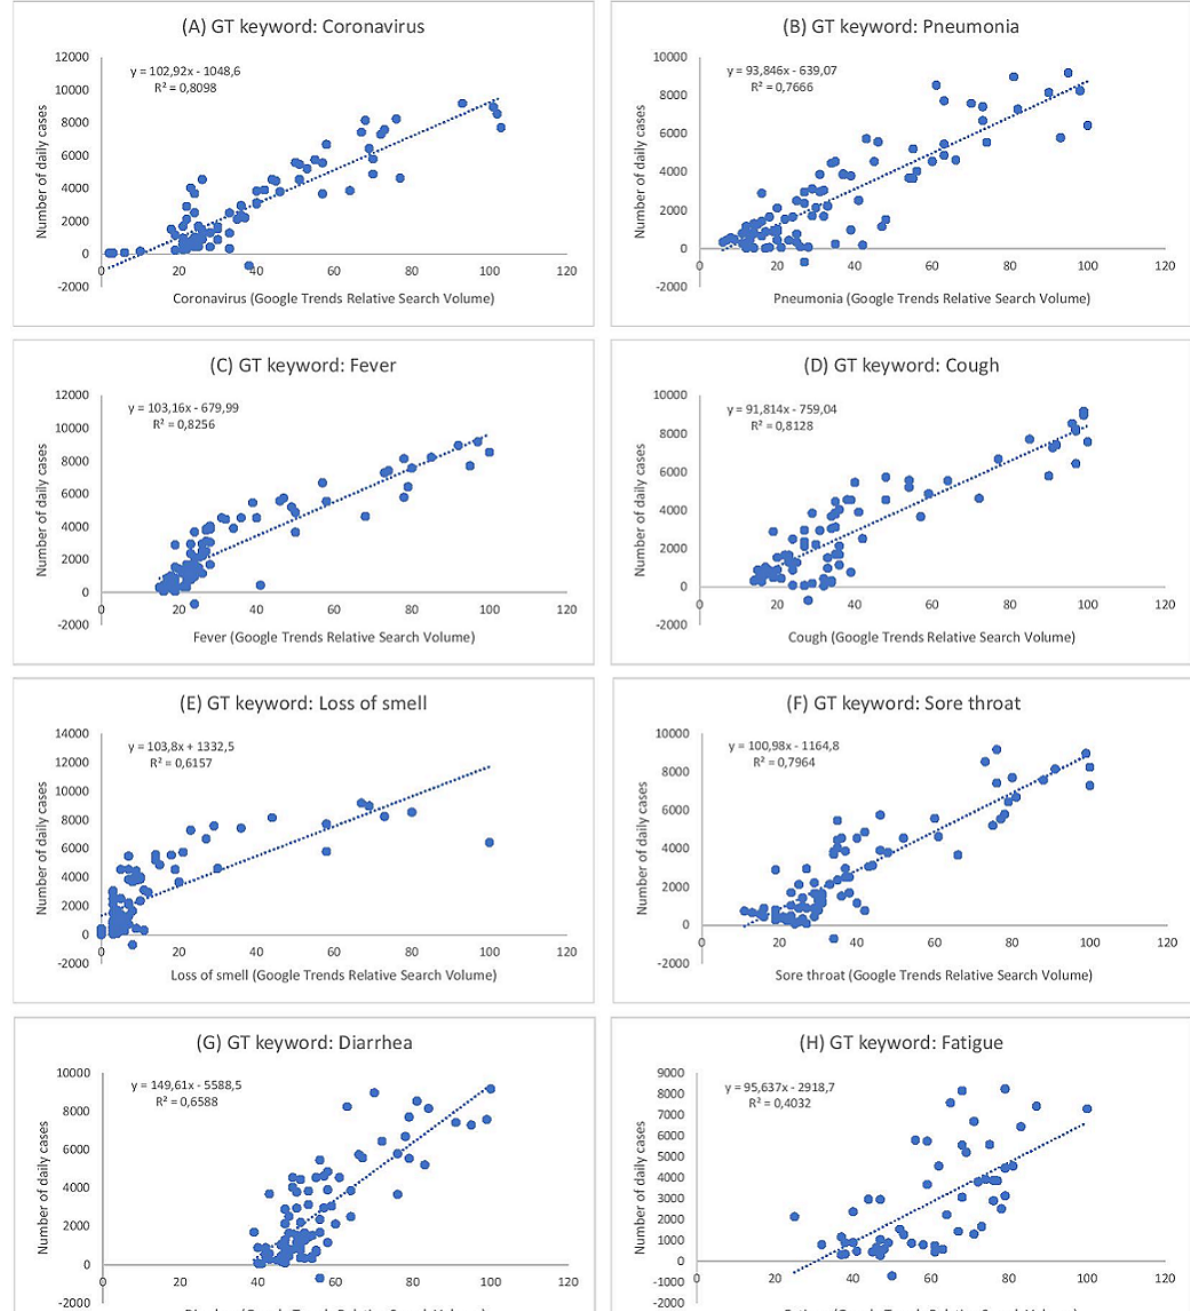
Figure 1. Scatter graphs depicting the linear trend in the relationships between daily PCR-positive confirmed COVID-19 cases and GT searches for COVID-19–related keywords in Spain from February to May, 2020. (A) Scatter graph between daily PCR-positive confirmed COVID-19 cases and GT search term Coronavirus. (B) Scatter graph between daily PCR-positive confirmed COVID-19 cases and GT search term Pneumonia. (C) Scatter graph between daily PCR-positive confirmed COVID-19 cases and GT search term Fever. (D) Scatter graph between daily PCR-positive confirmed COVID-19 cases and GT search term Cough. (E) Scatter graph between daily PCR-positive confirmed COVID-19 cases and GT search term Loss of smell. (F) Scatter graph between daily PCR-positive confirmed COVID-19 cases and GT search term Sore throat. (G) Scatter graph between daily PCR-positive confirmed COVID-19 cases and GT search term Diarrhea. (H) Scatter graph between daily PCR-positive confirmed COVID-19 cases and GT search term Fatigue. GT: Google Trends; PCR: polymerase chain